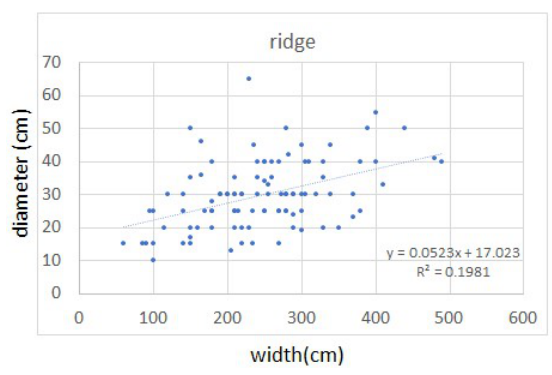
Figure 9 . Relationship between diameter and width of roots in